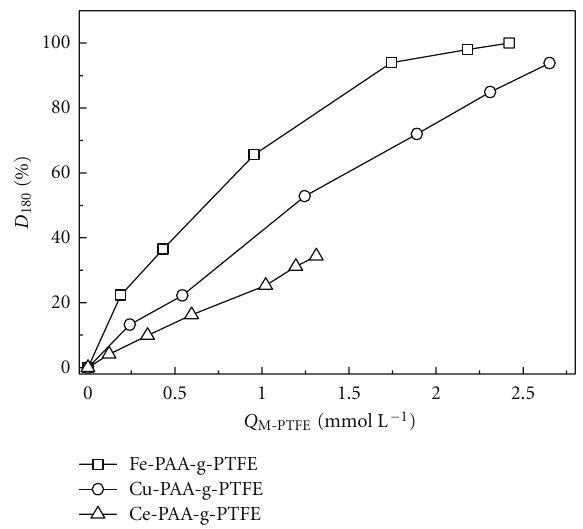
Figure 6: Relationship between Q M-PTFE and D 180